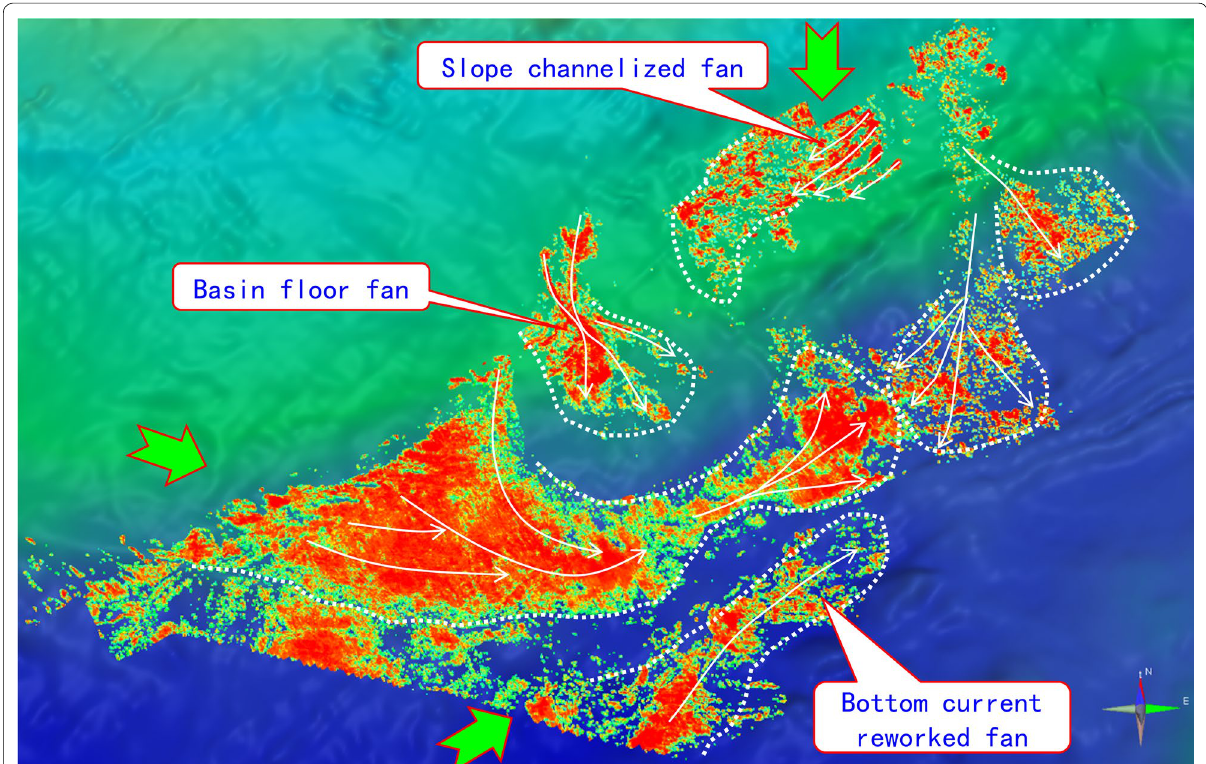
Fig. 5 The distribution and types of submarine fans of the Meishan Formation in the Ledong and Lingshui sags in work area A, Qiongdongnan Basin (location is shown in Fig.